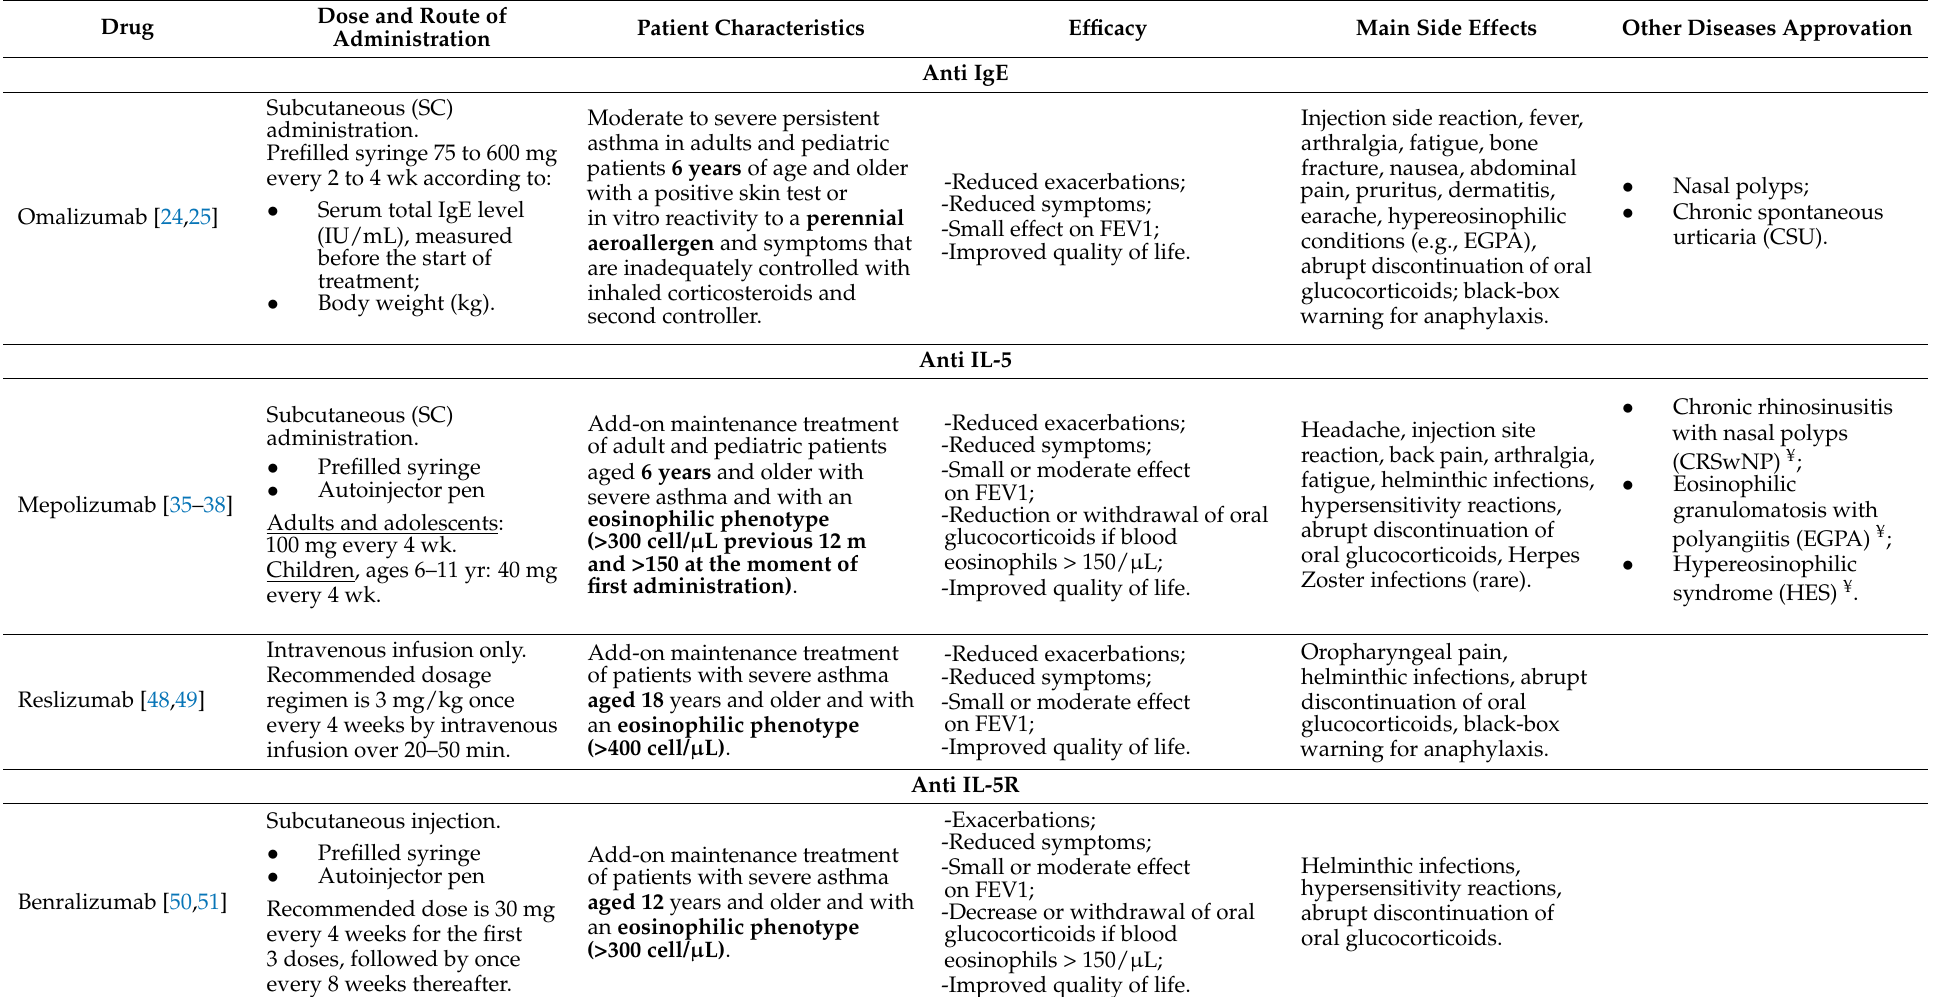
Table 2. Main characteristics of MABs in severe